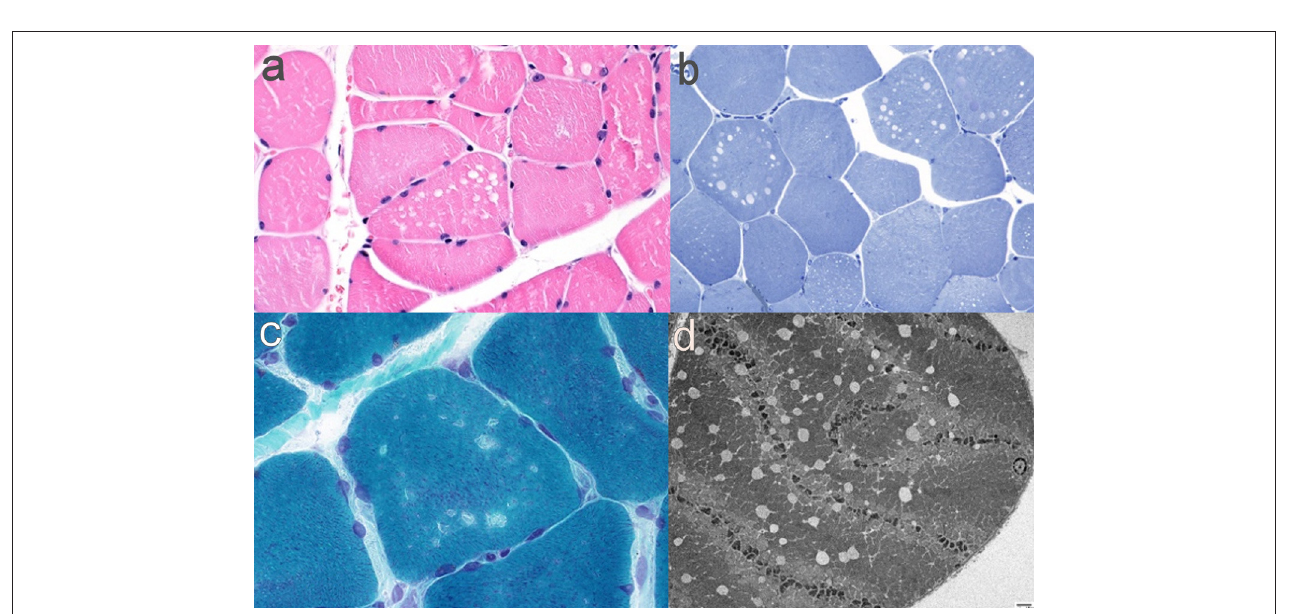
FIGURE 2 | Muscle pathology findings in Case 1. (a) H&E-FFPE (400x) showing non-rimmed vacuoles; (b) Gomori-trichrome (600x) with non-rimmed vacuoles; (c) Toluidine blue semi thin sections (400x) with empty vacuoles; (d) electron micrograph (1,000x) showing empty vacuoles and Z-line disarray.